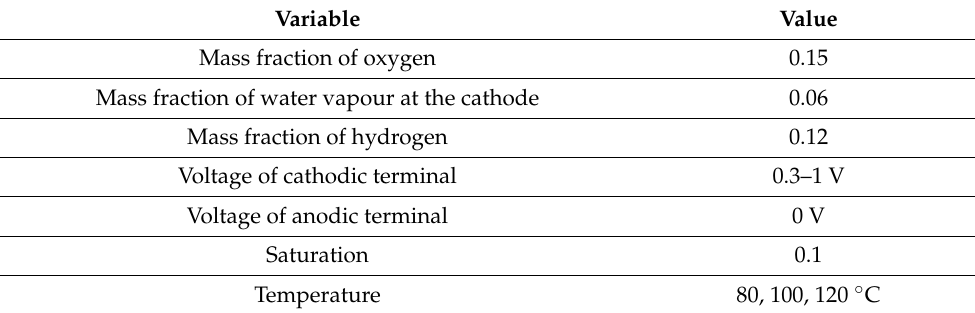
Table 3. Dirichlet boundary conditions used for the model. Note that boundary conditions water contents are calculated using Equation (22).